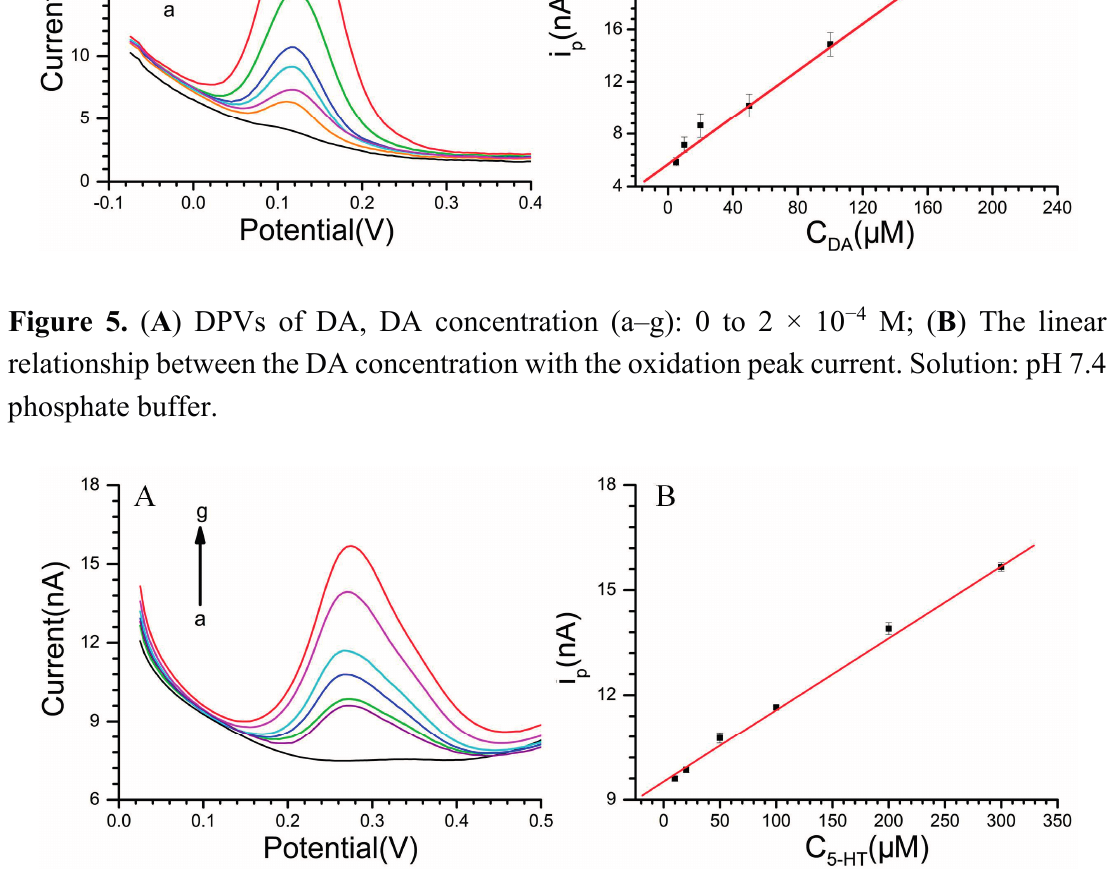
Figure 6. ( A ) DPVs of 5-HT, 5-HT concentration (a–g): 0 to 3 × 10 − 4 M; ( B ) The linear relationship between the 5-HT concentration with the oxidation peak current. Solution: pH 7.4 phosphate